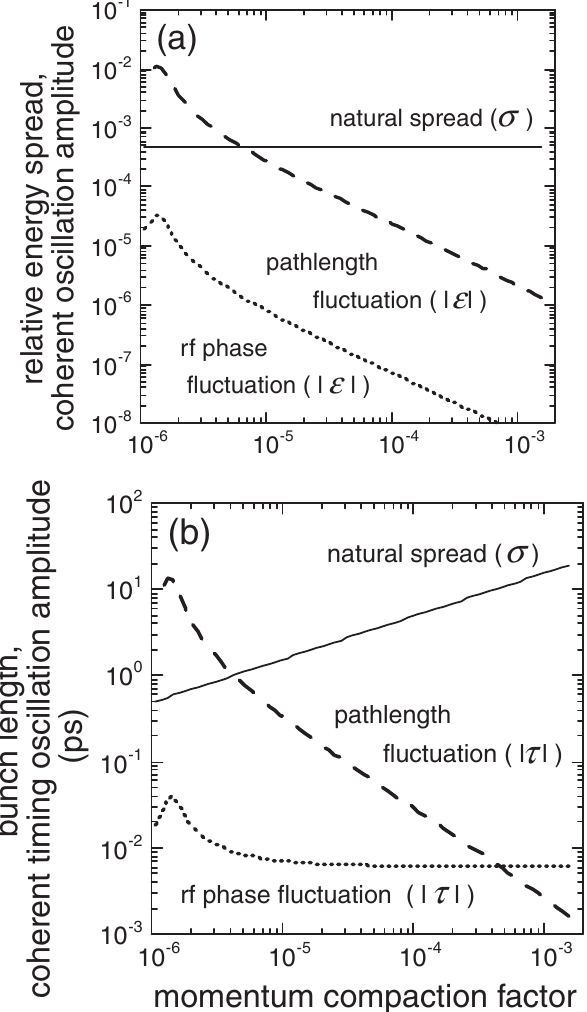
FIG. 4. Estimation of the energy oscillation (a) and phase oscillation (b) amplitudes at 180 Hz, as a function of the momentum compaction factor.